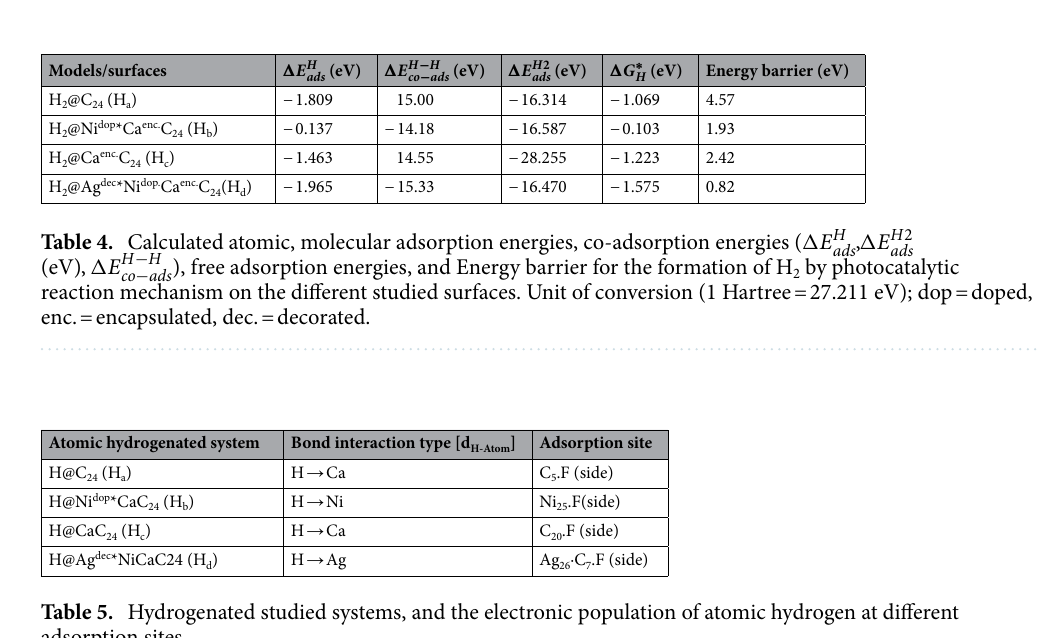
Models/surfaces